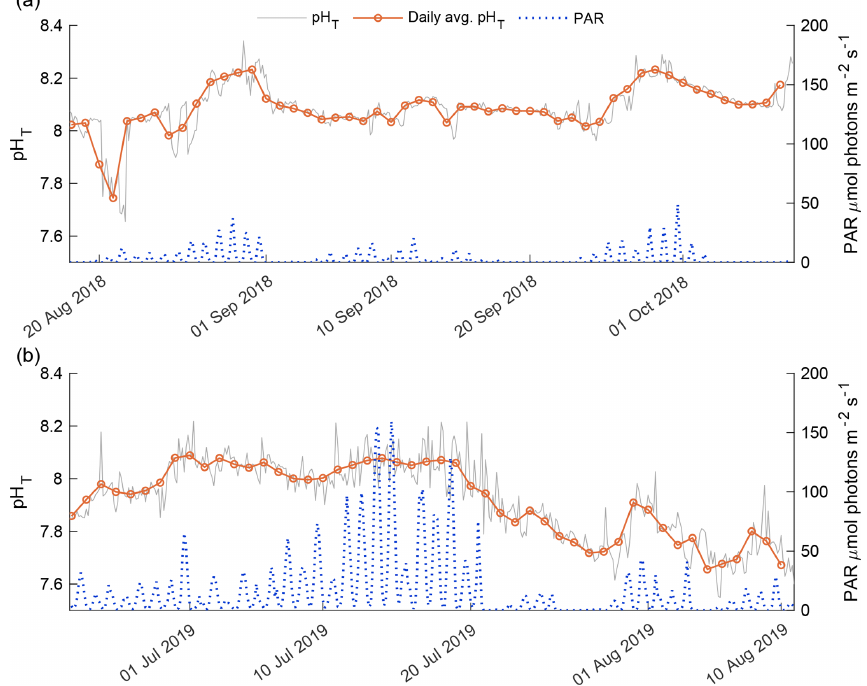
Figure 8. Detrended pH T (gray line) and PAR (blue dots) for the 2018 open phase (a) and 2019 open phase (b) . Daily average pH T (orange line) is displayed over the hourly variability.